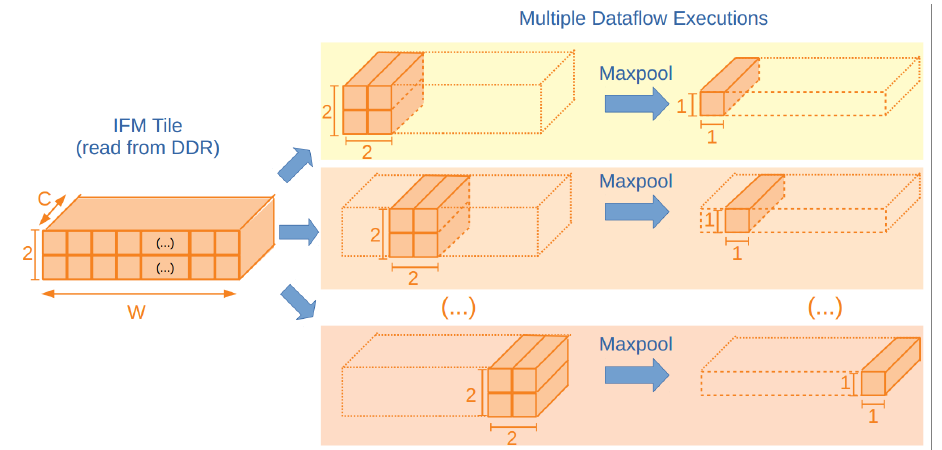
Figure 8. Input and output tiles for the maxpool layer